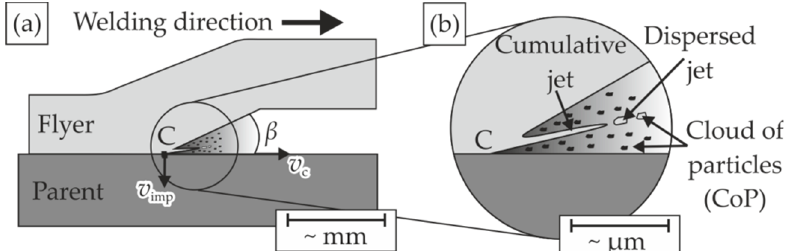
Figure 1. ( a ) Macroscopic scheme of the oblique high-speed collision of a metal pair and ( b ) microscopic view at the collision point C with differentiation between the jet as a cumulative or dispersed stream and the cloud of particles (CoP) that can consist of the dispersed jet, too.